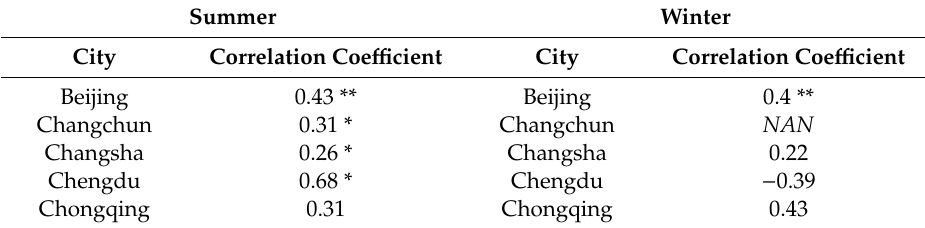
Table 1. The correlation coe ffi cients between normalized ∆ AOD and ∆ RH between urban and rural areas at all cities, where “*” and “**” means passing the significance test at the 0.05 and 0.01 levels, respectively. ‘NAN’ means no